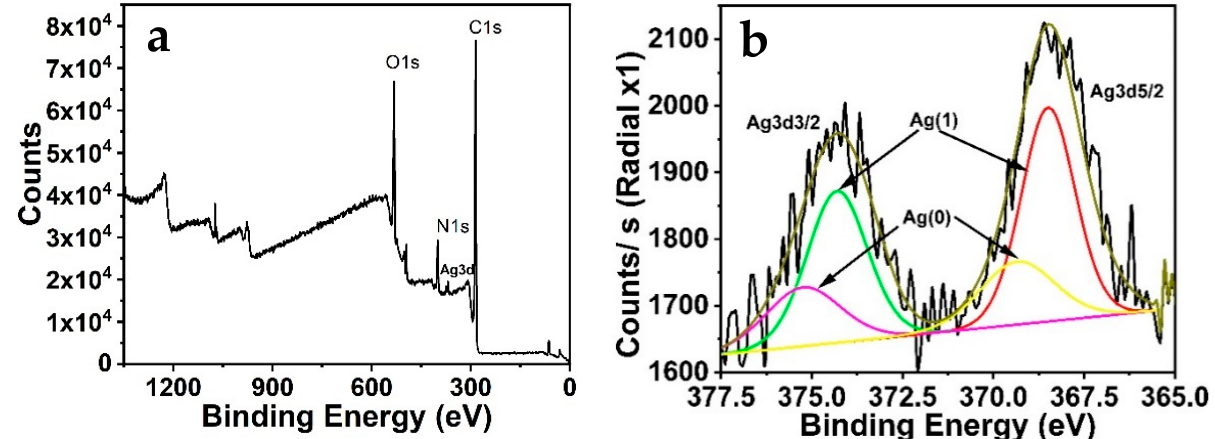
Figure 4. ( a ) XPS spectra of Ag3d for AgNCs; ( b ) The whole XPS spectrum of AgNCs.